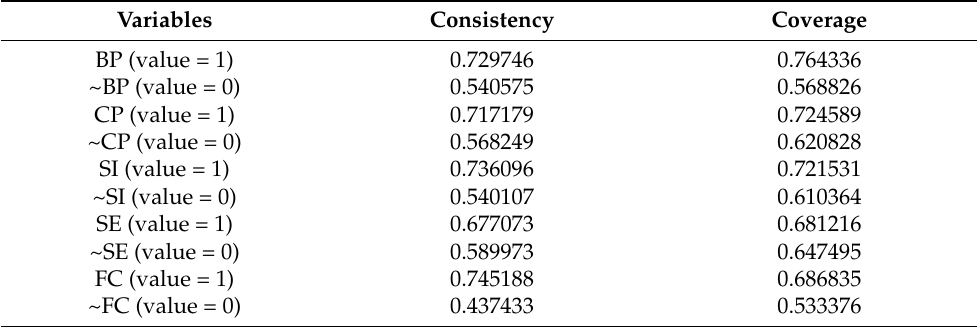
Table 9. Sufficient and Necessary Analysis of Antecedent